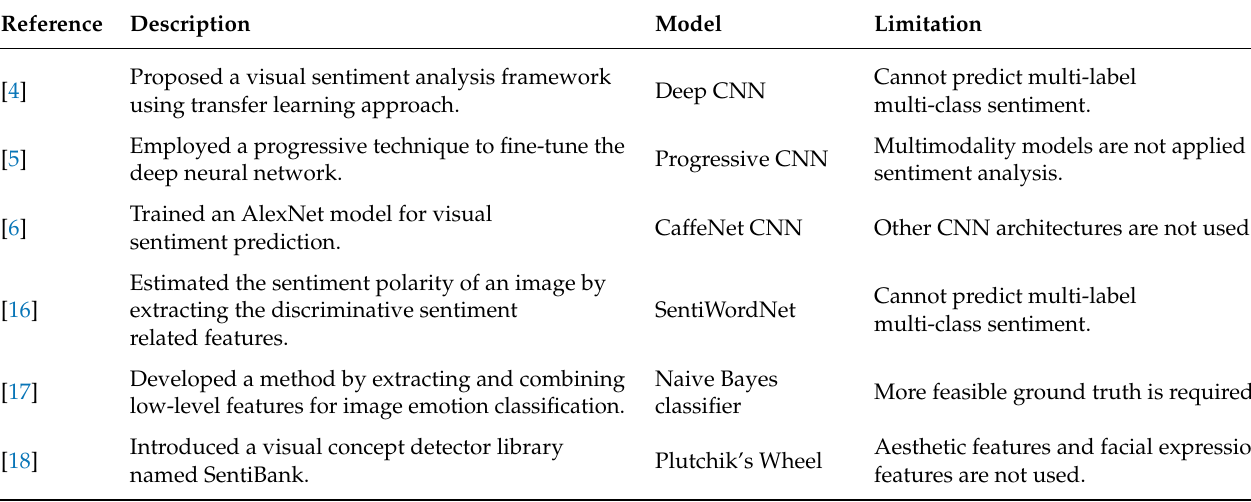
Table 1. Related